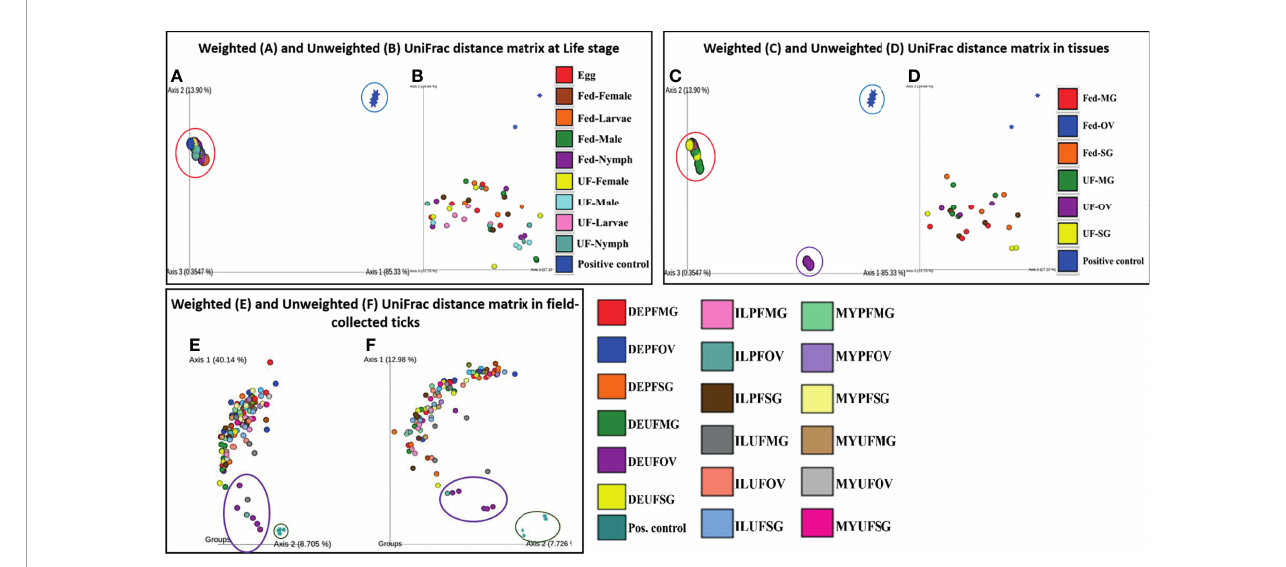
FIGURE 5 | Beta diversity metrics. Emperor plot of PCoA analysis of the weighted and unweighted UniFrac distance matrix across (A, B) different life stage and (C, D) tissues of lab raised ticks. Representative PCoA analysis of (E) weighted and (F) unweighted UniFrac distance matrix from fi eld-collected ticks. Each colored ellipse corresponds to uniquely clustering patterns of biological replicates. Each point represents the bacterial microbiome of an individual tick or dissected tissue. UF-unfed, PF-partially fed, SG-salivary gland, MG-midgut, OV-ovary, DE-Delaware, IL-Illinois,